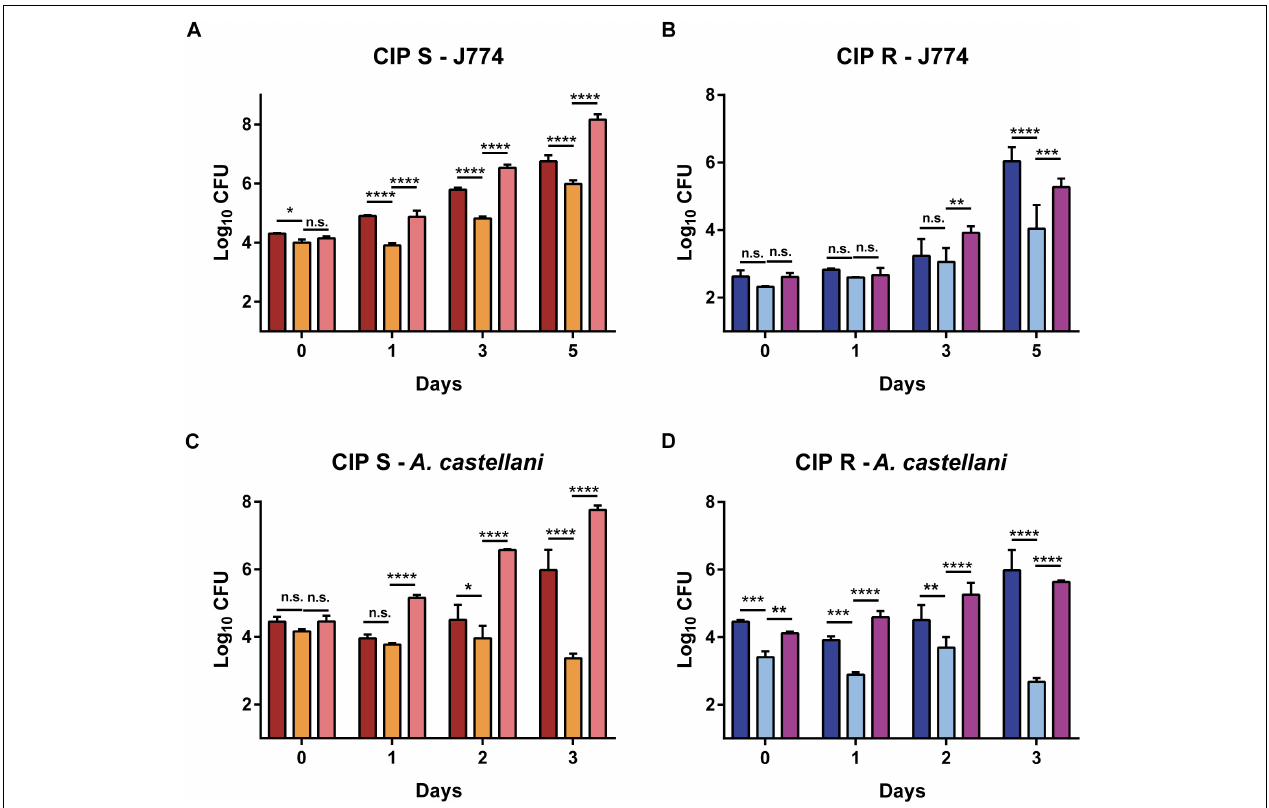
FIGURE 5 | Intracellular growth of (cid:49) lsr2 mutants in macrophages (A,B) and in amoebae (C,D) . Murine J774.2 macrophages were infected with CIP104536 (Collection Institut Pasteur) Mabs-S (in red) and Mabs-R (dark blue), Mabs-S- (cid:49) lsr2 (orange) and Mabs-R- (cid:49) lsr2 (light blue) and their respective complemented strains (C- (cid:49) lsr2 ; pink for S and mauve for R) at a MOI 1 whereas A. castellanii cells were infected with the same strains at a MOI 10. Intracellular growth was assessed by CFU counting for 5 days in macrophages and 3 days in amoebae. CFU histograms with error bars represent means ± SD calculated using data from two independent experiments. Differences between means were analyzed by two-way ANOVA and the Tukey post-test, allowing multiple comparisons. ns, non-significant, ∗ P < 0.05, ∗∗ P < 0.01, ∗∗∗ P < 0.001, and ∗∗∗∗ P <